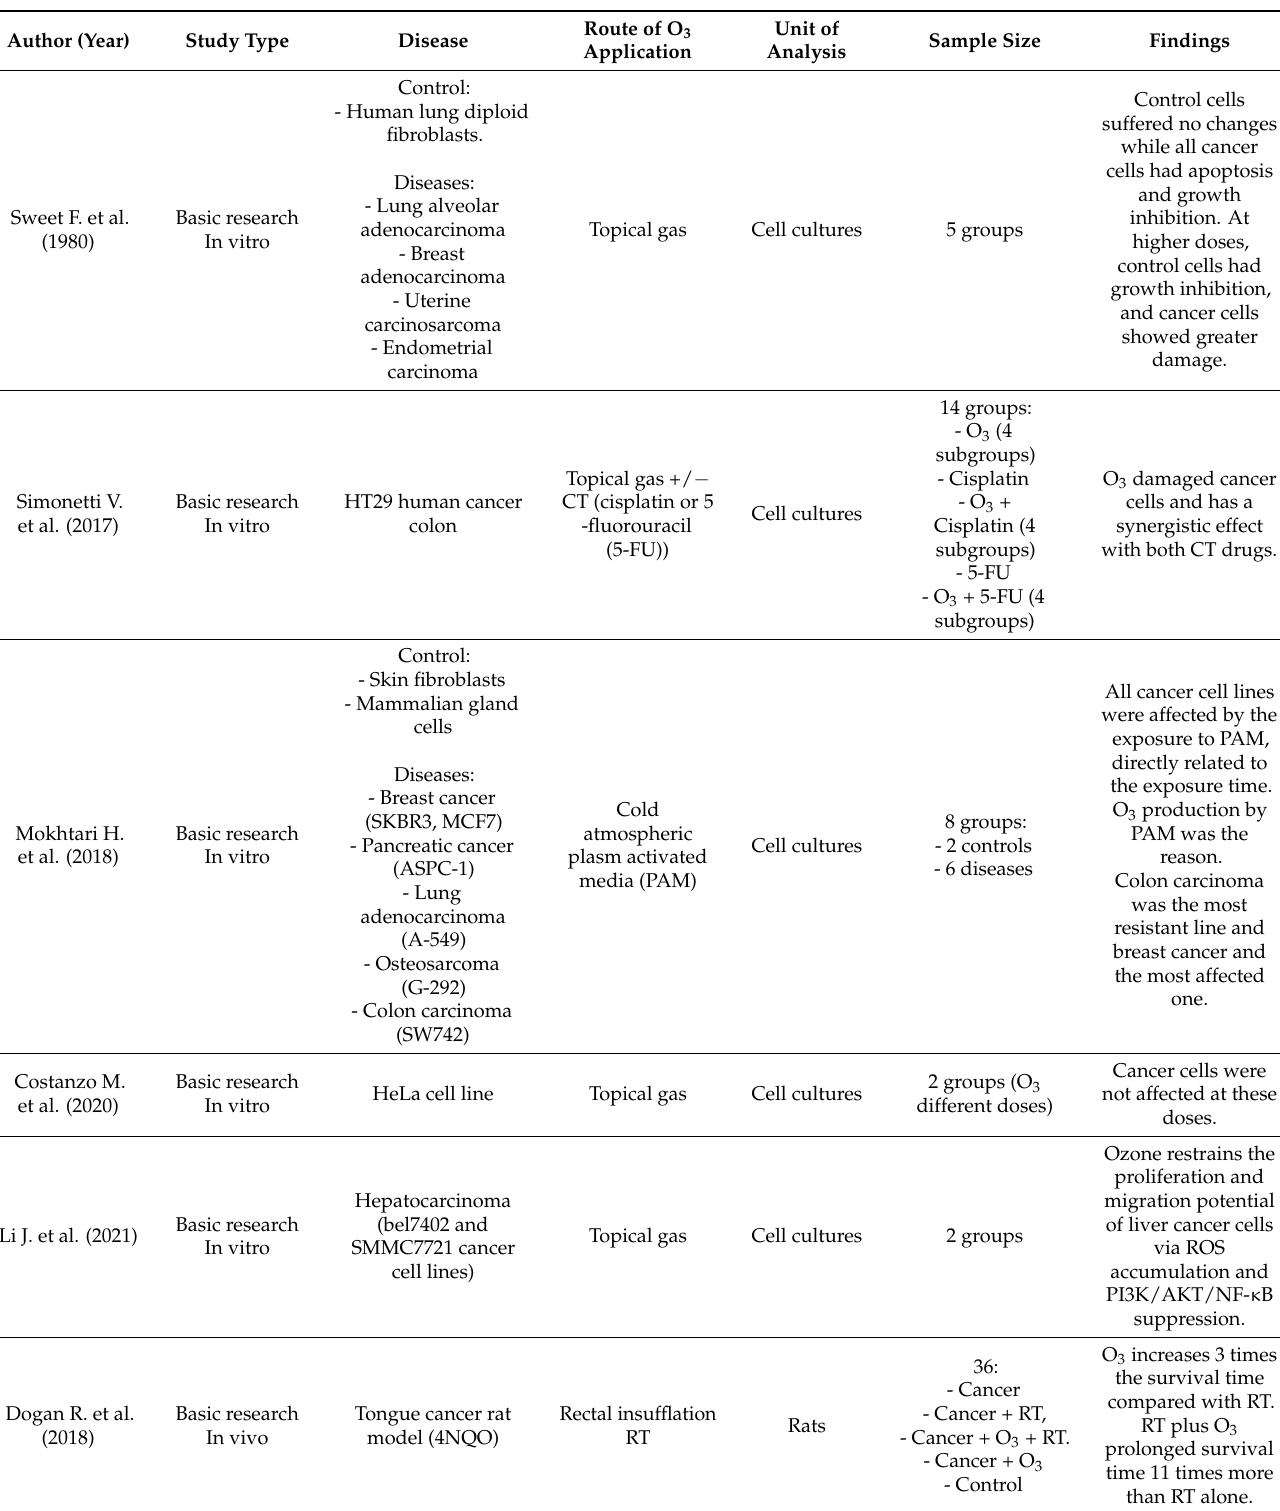
Table 1. Papers retrieved from direct search in PubMed. See Figure 2 for